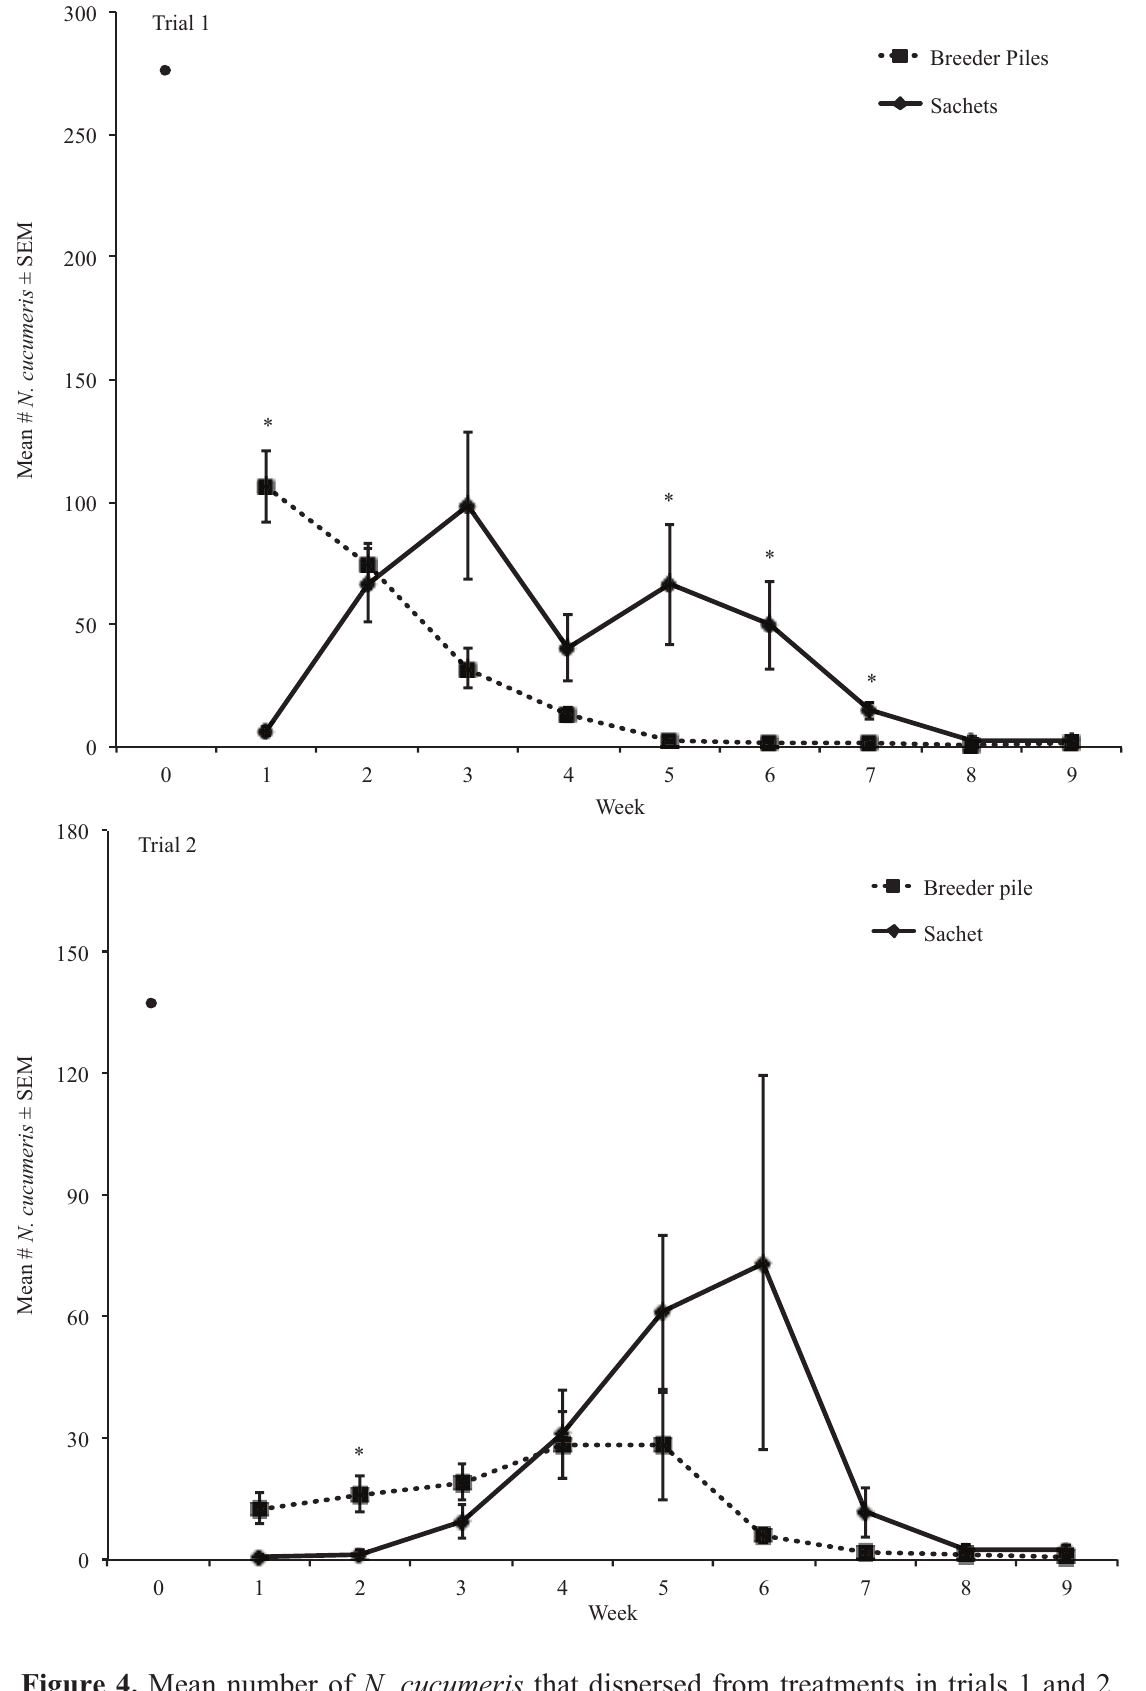
Figure 4. Mean number of N. cucumeris that dispersed from treatments in trials 1 and 2. * Means are significantly different among treatments in the same sampling period ( Tukey’s HSD, α =